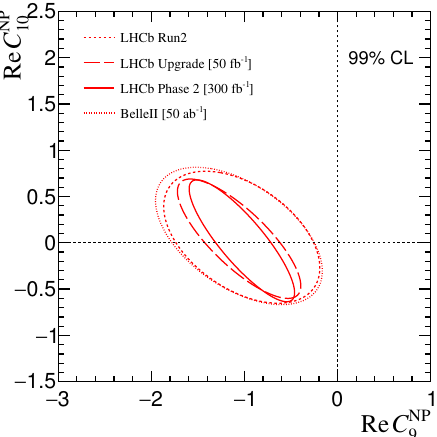
Figure 6 . Two-dimensional sensitivity scans for the pair of Wilson coe(cid:14)cients C NP the expected statistics corresponding to LHCb Run II (dotted), LHCb Upgrade [50 fb (cid:0) 1 ] (dashed), LHCb Upgrade [300 fb (cid:0) 1 ] (solid) and Belle II [50 ab (cid:0) 1 ] (long dashed). The contours correspond to 3 (cid:27) statistical-only uncertainty bands obtained with z 3 (cid:12)ts.